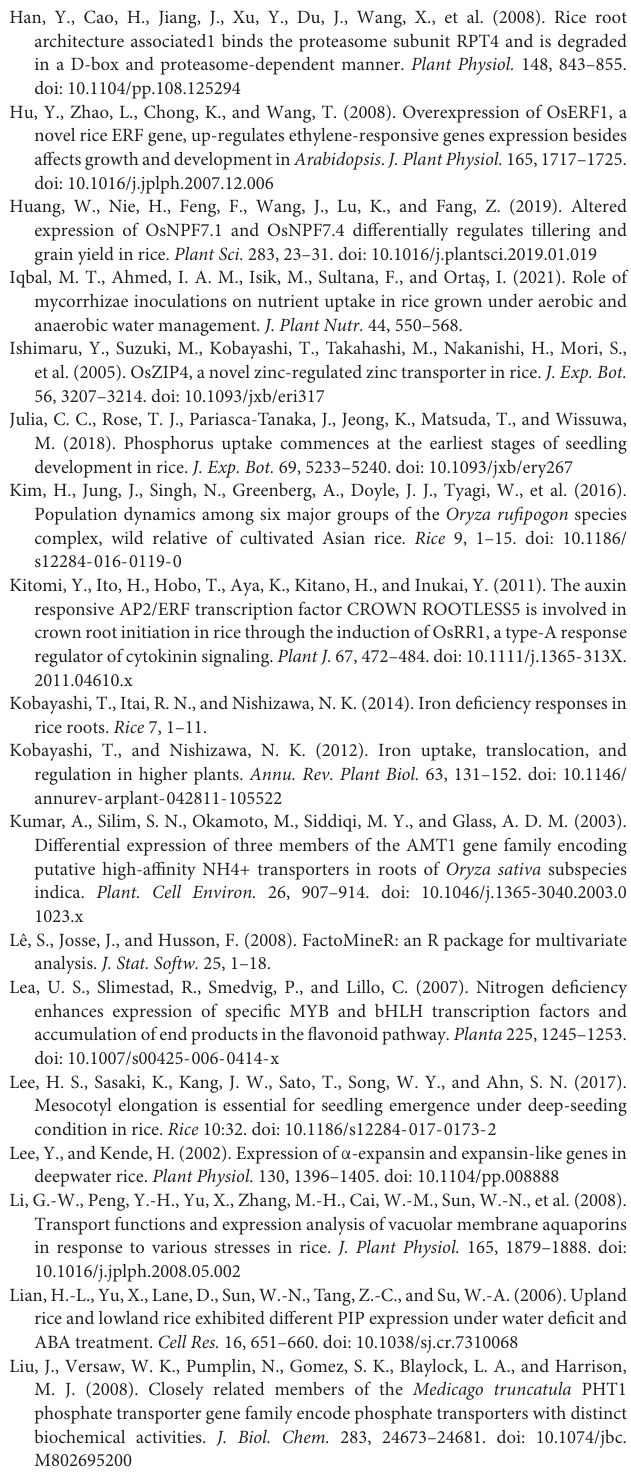
Supplementary Figure 2 | Manhattan plots from GWA mapping of early root traits at 14 and 28 days under DSR condition of BAAP population in dry season. Benjamini–Hochberg adjusted probabilities > 0.1 are highlighted in the red dot. The diagonal blue line shown on QQ Plots represents a 1:1 agreement between expected probability. Candidate gene of notable QTL is shown on the